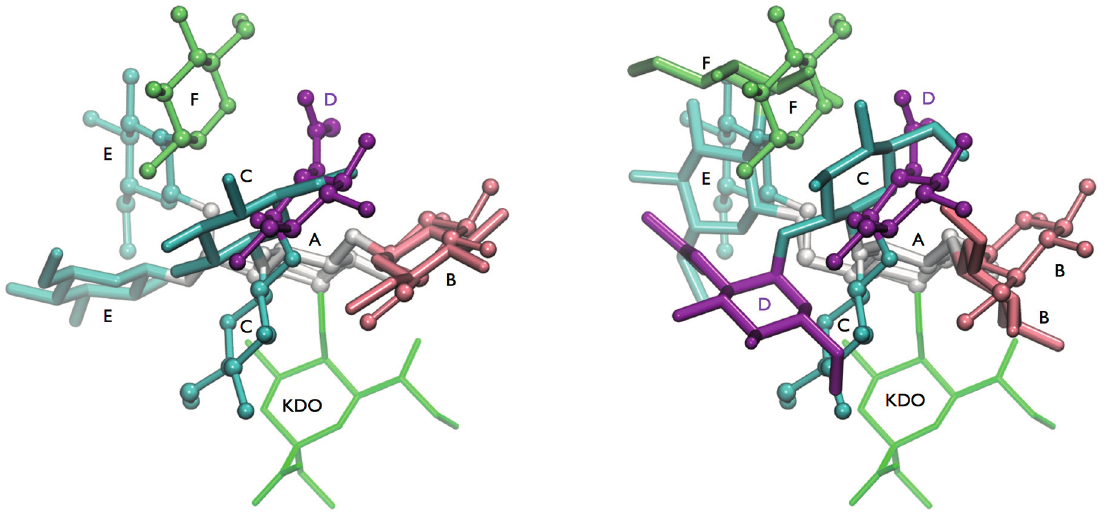
Figure 8. Overview on conformations found for the highly branched glucose-rich inner core of lipooligosaccharide of M. catarrhalis . ( Left ) Comparison of the energy minimum conformation of lgt1/4 Δ OS (stick) and the “(1-4)anti- ψ (1-6) gg ” conformation of lgt2 Δ OS (cpk); ( Right ) Comparison of the “(1-4)anti- ψ (1-6) gg ” conformation (cpk) of lgt2 Δ OS and a conformation that has the (1-4)-linkage in minimum A and the (1-3)-linkage in minimum B. The terminal GlcNAc residue (D) is shown in